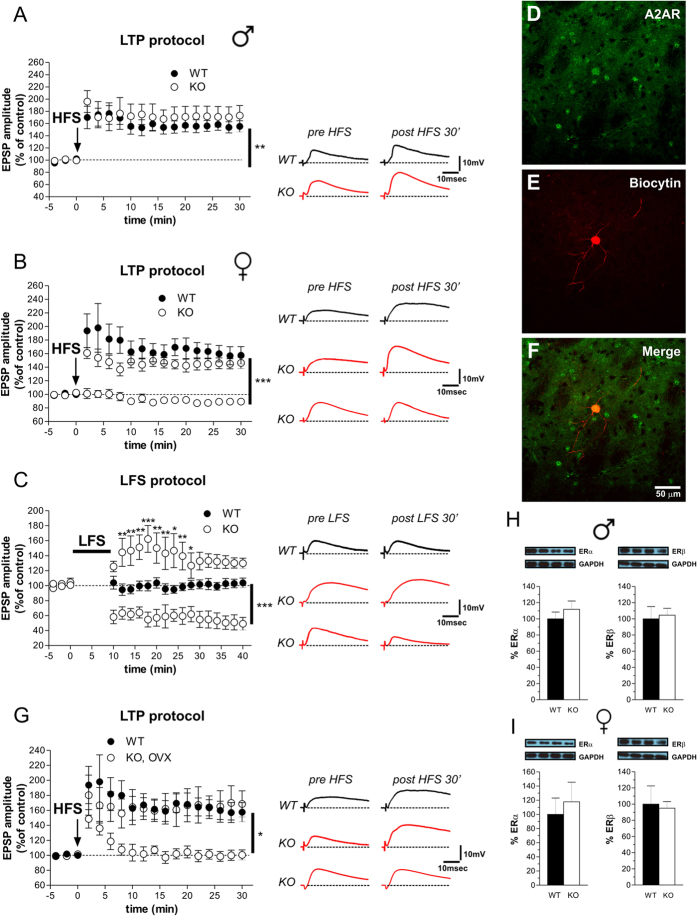
Long-term potentiation in MSNs of Rhes mutant mice and morphological characterization.(A) Time-course plots of EPSP amplitude (left) and pairs of traces (right) demonstrate the presence of HFS-induced LTP in MSNs recorded from slices of male WT (n = 5) and KO (n = 7) mice (Student’s t-test, pre- vs. 30 min post-HFS, **p < 0.01). (B) Time course graphs of the EPSC amplitude (left) and pairs of traces (right) show the induction (n = 12) or the complete loss (n = 15) of LTP in MSNs from female KO mice compared with age-matched WT animals (n = 5) (Student’s t-test at 30 min post-HFS, WT vs. KO with LTP, p > 0.05, WT vs. KO with no LTP, ***p < 0.001). (C) In KO females application of a low-frequency stimulation (LFS) induced a decrease of EPSP amplitude in 5 of 9 MSNs recorded and a mild potentiation in the remaining 4 MSNs, whereas the same protocol induced no change of synaptic activity in all the MSNs (n = 7) recorded from WT females (Bonferroni post-hoc: WT vs. KO with LTP, *p < 0.05; **p < 0.01; ***p < 0.001; Student’s t-test at 30 min post-HFS: WT vs. KO with a depression of EPSP, ***p < 0.001). (D–F) Confocal laser scanning microscopy (CLSM) images of double-labeled immunofluorescence for biocytin and adenosine receptor (A2AR). Biocytin immunolabeling is visualized in red streptavidin-Cy3 immunofluorescence (D) and A2AR is visualized in green Cy2 immunofluorescence (E). The colocalization of A2AR and biocytin is showed in merged panel (F) as yellow fluorescence. (G) HFS protocol applied in the MSNs of ovariectomized (OVX) KO females induced LTP in 6 of 12 MSNs recorded (Student’s t-test at 30 min post-HFS: WT vs. KO OVX with no LTP, *p < 0.05). (H,I) Striatal ERα and ERβ, determined by Western blotting, in WT and KO male (n = 6 /genotype per ERα; n = 6 WT, 5 KO per EPβ) (H) and female (n = 5 WT, 6 KO per ERα; n = 6 /genotype per ERβ) (I) mice. The top panels show representative blots comparing the different genotypes. All data are expressed as mean ± SEM. Genotypes are as indicated.